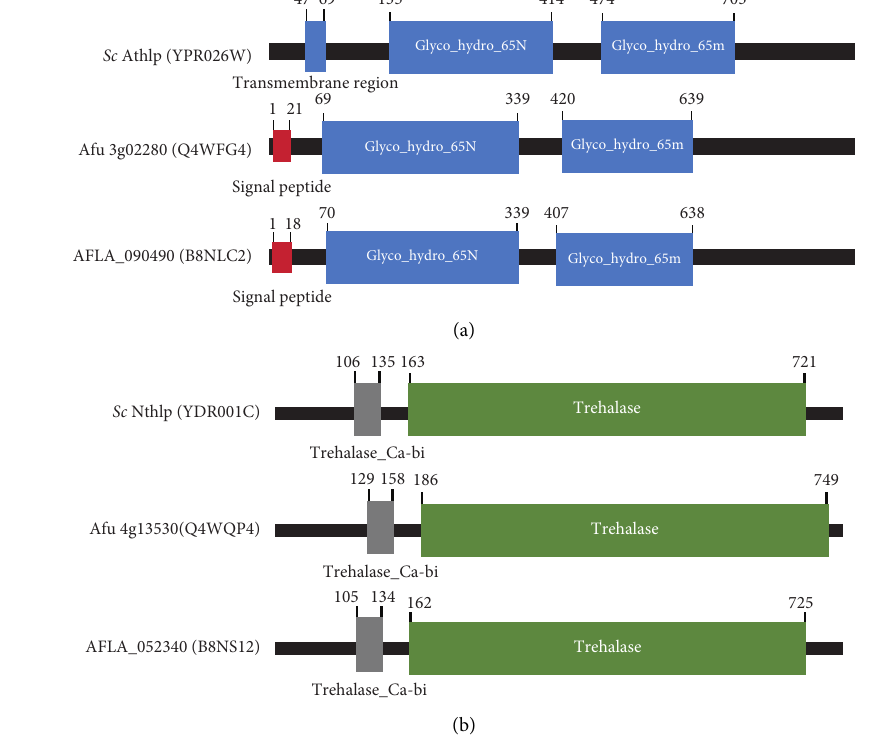
Figure 1: Aspergillus flavus possesses trehalase homologs. (a) Percentages of identity and similarity of Sc Ath1p (YPR026W):AFLA_090490 (B8NLC2) and Afu3g02280 (Q4WFG4):AFLA_090490 (B8NLC2) from BLASTp analyses are 29% identity, 46% similarity and 68% identity, 81% similarity, respectively. Sc Ath1p, Saccharomyces cerevisiae acid trehalase protein; Afu, Aspergillus fumigatus ; AFLA, Aspergillus flavus ; glycosyl hydrolase family 65 (Glyco_hydro_65N; Glyco_hydro_65m) (adapted from SMARTanalyses (http://smart.embl-heidelberg.de/)).(b) Percentages of identity and similarity of Sc Nth1p (YDR001C):AFLA_052438 (B8NS12) and Afu4g13530 (Q4WQP4):AFLA_052438 (B8NS12) from BLASTp analysesare 55% identity,69% similarityand 81%identity,88% similarity,respectively. Sc Nth1p, Saccharomycescerevisiae neutraltrehalaseprotein; Afu , Aspergillus fumigatus ; AFLA, Aspergillus flavus ; Trehalase_Ca-bi: neutral trehalase calcium-binding domain; trehalase: trehalose hydrolysis domain (adapted from SMART analyses